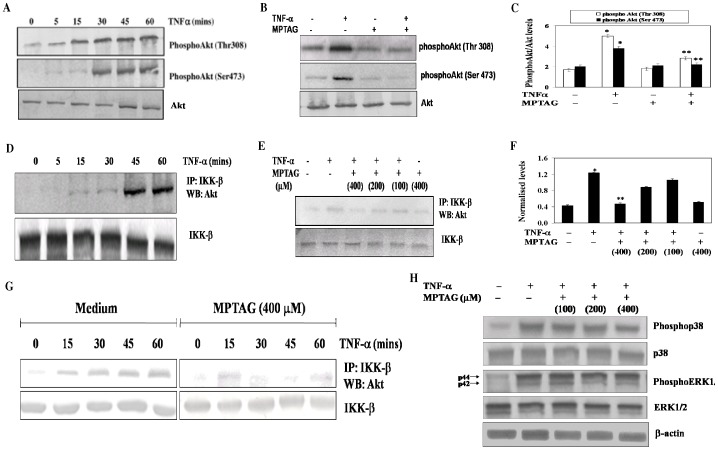
MPTAG inhibits the TNF-α-induced Akt activation and its association with IKK-β.(A) The cells were induced with TNF-α (10 ng/ml) for the indicated times. The total cell extracts were prepared and subjected to western blot analysis using anti-phosphoAkt, for both Ser473 and Thr308 residues, and anti-Akt antibodies. (B) The cells were treated with MPTAG (400 µM) and induced with TNF-α for 30 mins followed by western blot analysis as stated above. (C) The intensity of bands were densitometrically scanned and normalized with total Akt levels. The values presented are mean ± SEM. *p<0.05 vs. uninduced cells; **p<0.05 vs. TNF-α-induced cells, statistical significance was set at p<0.05. (D) The cells were induced with TNF-α (10 ng/ml) for the indicated times. The total cell extracts were prepared and immunoprecipitated with anti-IKK-β antibody followed by western blot analysis with anti-Akt and anti-IKK-β antibodies. (E) The cells were pretreated with MPTAG at varying concentrations and induced with TNF-α for 30 mins. The total cell extracts were prepared and processed as stated above and analyzed for western blot as stated above. (F) The intensity of bands were densitometrically scanned and normalized with IKK-β levels. (G) The cells were pretreated with 400 µM MPTAG and then stimulated with 10 ng/ml TNF-α for the indicated times. The total cell extracts were prepared, immunoprecipitated with anti-IKK-β antibody and analyzed by western blot using anti-Akt and anti-IKK-β antibodies. (H) Effect of MPTAG on TNF-α-induced p38 MAPK and ERK1/2 activation. The cells were treated with MPTAG and induced with TNF-α as stated above. The total cell extracts were prepared and analyzed by western blot using anti-phosphospecific p38 MAPK and ERK1/2 antibodies. The same membrane was reblotted with anti-p38 MAPK, ERK 1/2 and β-actin antibodies. The values presented are mean ± SEM. *p<0.05 vs. uninduced cells; **p<0.05 vs. TNF-α-induced cells, statistical significance was set at p<0.05.